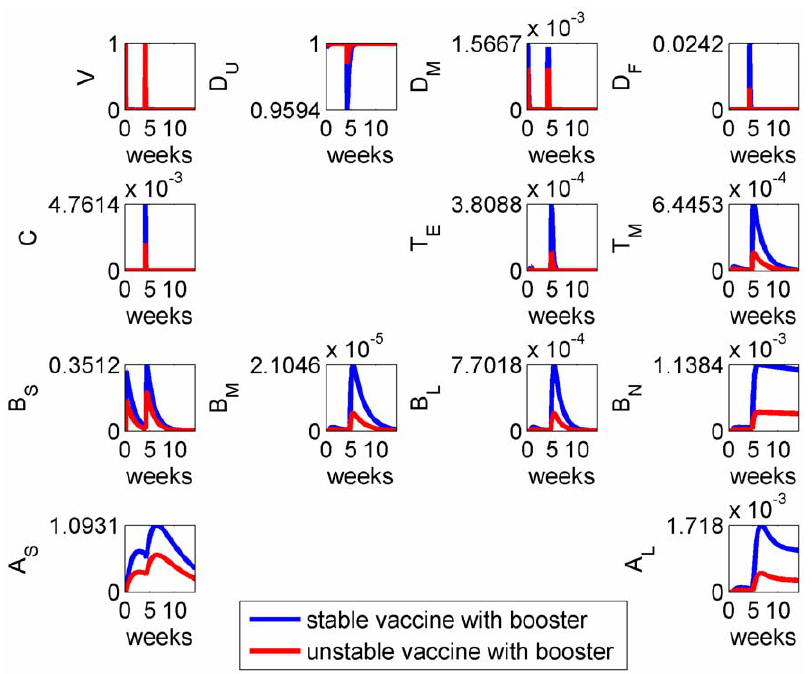
Figure 5. Model results for the system with stable (blue) and unstable (red) vaccine, in response to a second (booster) vaccine dose administered approximately 4 weeks after the initial one.